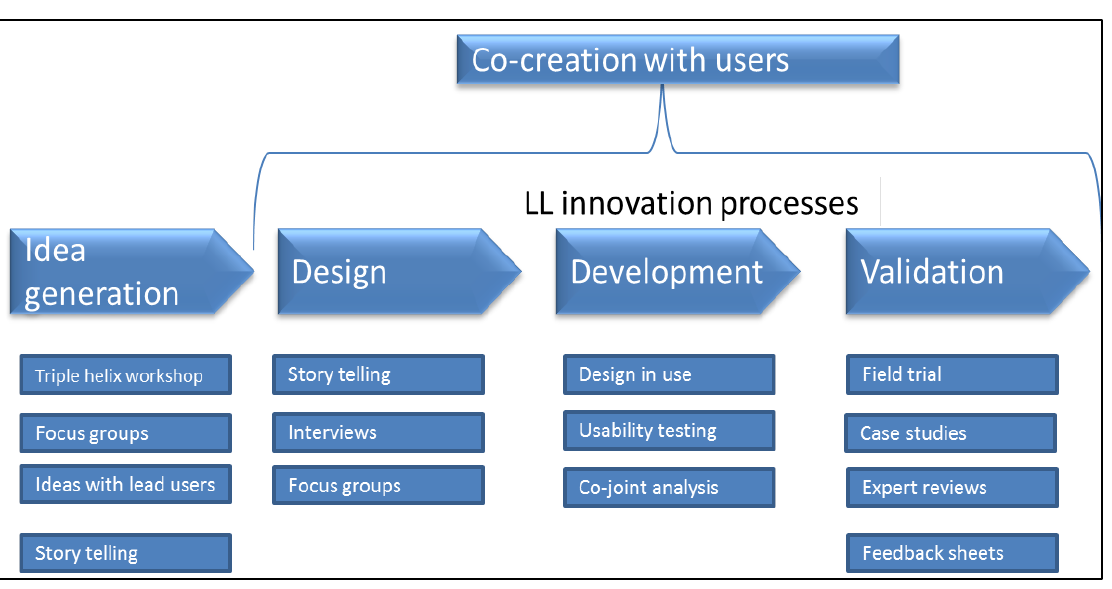
Figure 3: Role of users as co-creators during innovation processes Source: Adapted from Guzmán et al.